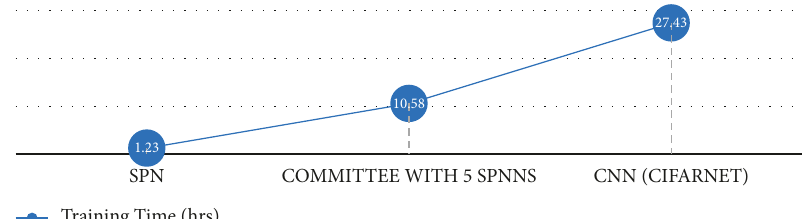
Figure 6: Training time of the deep learning models addressed: SPNN, committee with 5 SPNNs, and CNN, considering 30